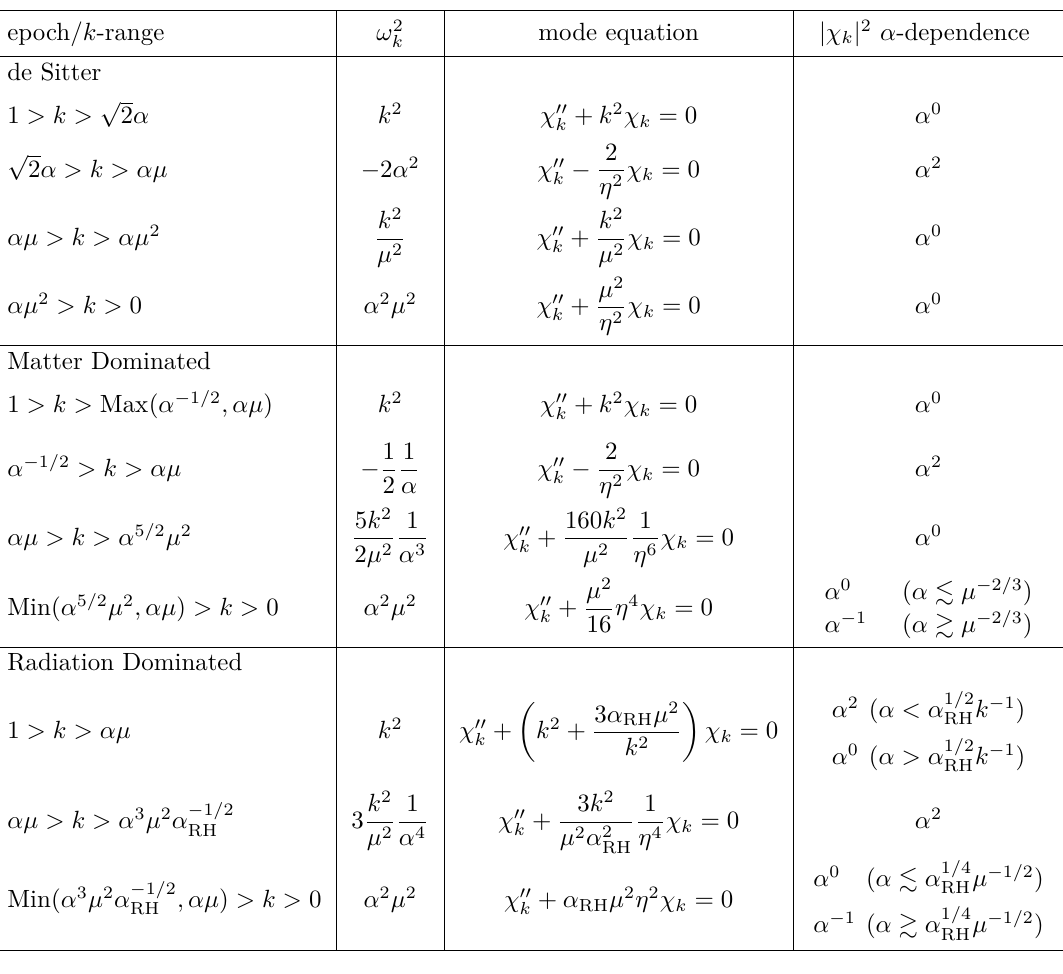
Table 3 . Relevant solutions to the wave equation assuming a single term in ω 2